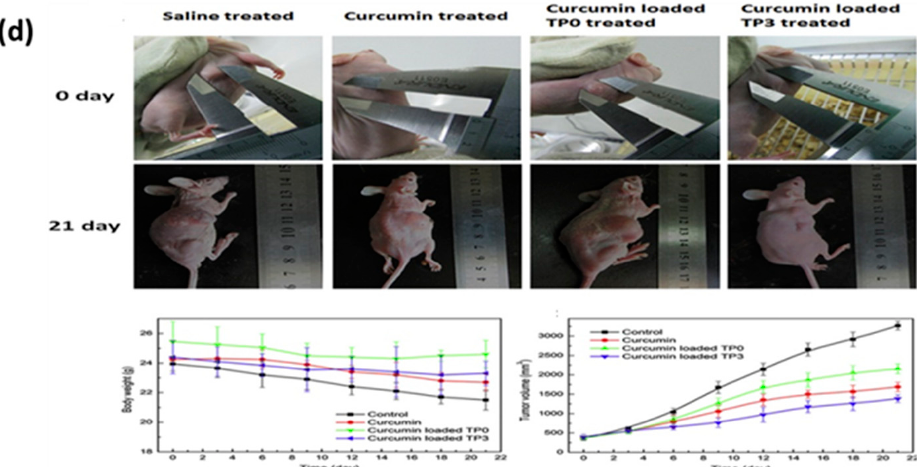
Figure 17. Scheme of preparation of injectable hydrogel by Micheal addition crosslinking between thiolated chitosan and poly(ethylene glycol) diacrylate (TCS/PEGDA) for localized intratumoral delivery of curcumin ( a ); curcumin release behavior from TCS/PEGDA injectable hydrogel in PBS buffer at 37 °C with shaking (100 rpm) ( b ); HepG2 cells viability determined using MTT assay when incubated with free curcumin, and curcumin loaded TCS/PEGDA injectable hydrogels with (TP3) or without lysozyme, (TP0) respectively. Values are normalized to controls (cells without exposure to curcumin or hydrogels). ( c ); H&E staining of tumor, heart, liver, lung, and kidney tissue sections from tumor-bearing nude mice (scale bar: 50 μ m) ( d ) and Histological analysis by hematoxylin and eosin staining of tumor, heart, liver, lung and kidney tissue from tumor-bearing nude mice (scale bar: 50 μ m) (adapted with permission from Piao Ning et al., 2022).